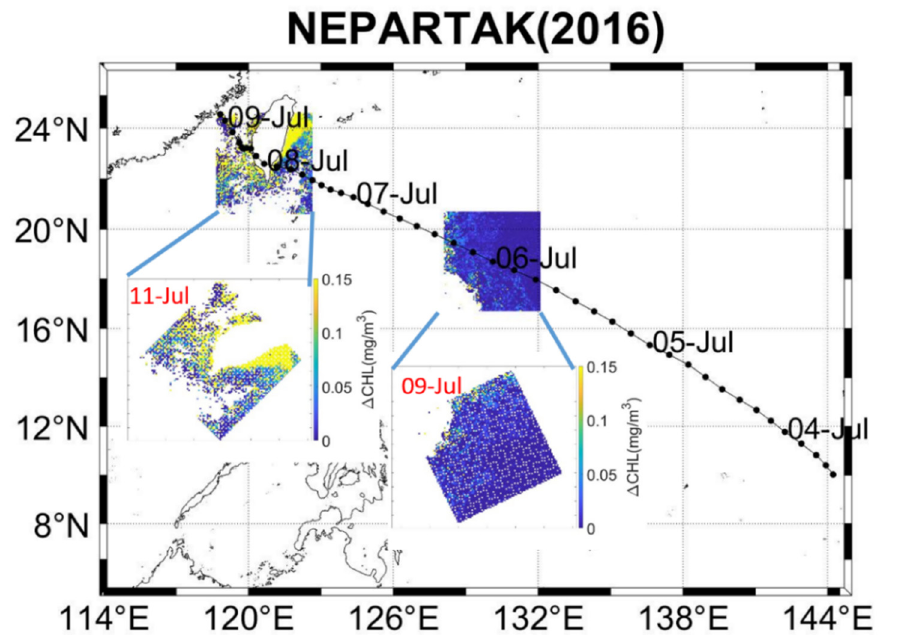
Figure 5. Schematic plot of the procedure for processing and compositing a normalized spatial characteristic of TICR (in a polar coordinate system). Black dots represent the track of typhoon Nepartak, and red texts are the dates of images from Himawari-8 for compositing.